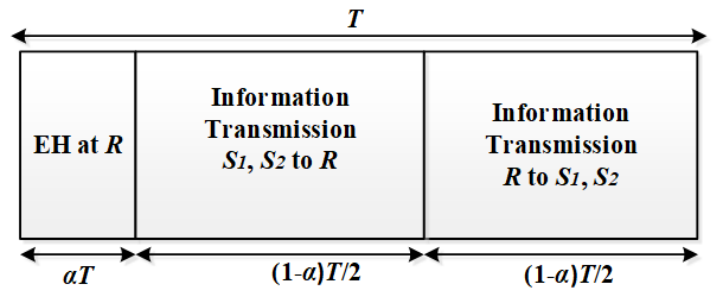
Figure 2. The energy harvesting and information processing in the system